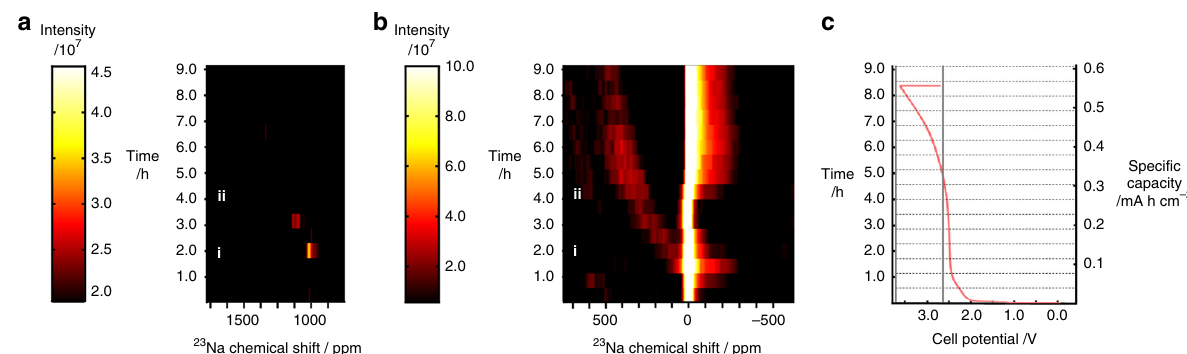
Fig. 5 In operando 23 Na NMR spectra and electrochemistry during a formation charge/discharge cycle. 2D intensity plots of 23 Na chemical shift, for regions around metallic signal ( a ) and solvated sodium ( b ), as a function of time, during the formation charge/discharge cycle at a speci fi c current of 30 mA g − 1 . c Corresponding charge pro fi le of the formation cycle. Spectra for time points i and ii, indicated in a and b , are shown in Fig. 6b and c, respectively.